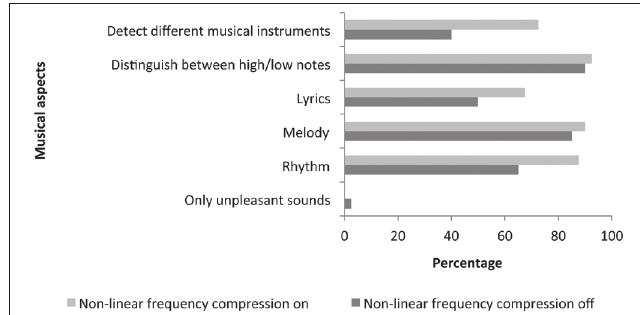
Fig. 10. Participants’ ability to discriminate between different musical aspects with NFC off versus NFC